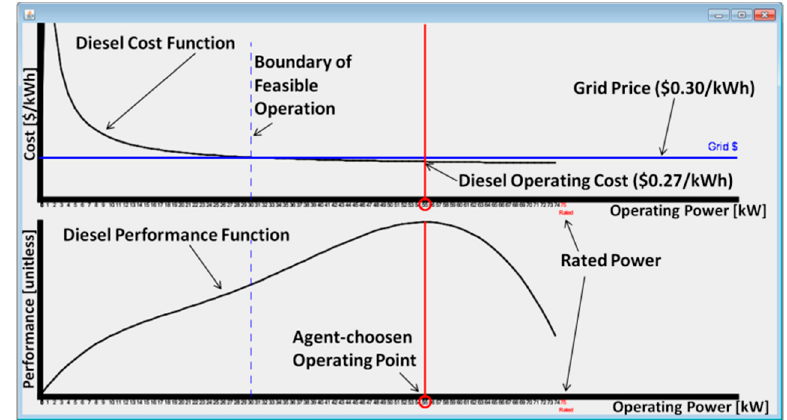
Figure 9. Diesel producer agent cost and grid price of electricity ( top ) and diesel performance function ( bottom ), after sudden grid price hike.